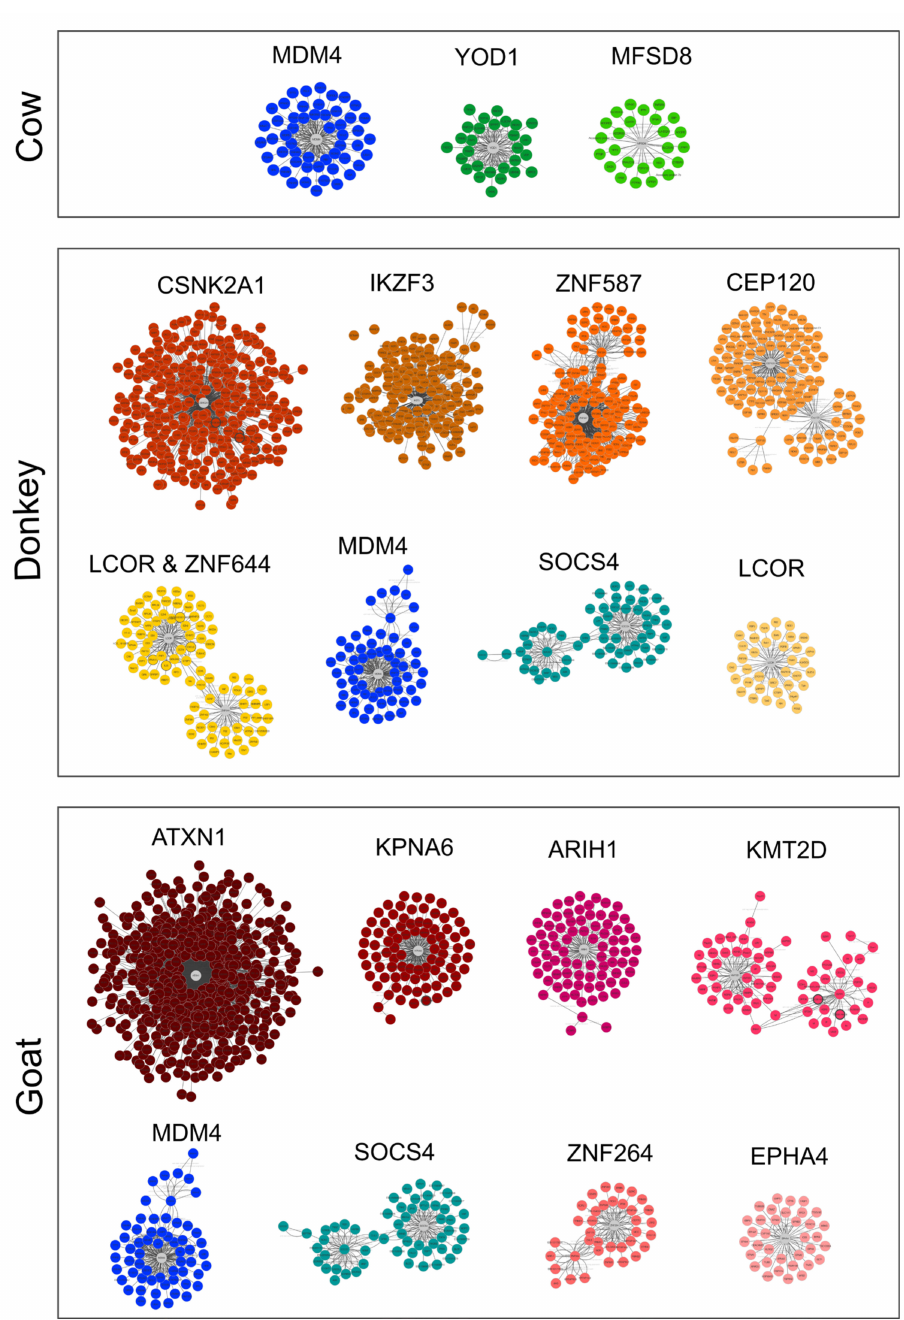
Figure 4. Clusters of proteins generated by clusterMaker 2.0 Cytoscape application starting from the PPI network. Central nodes (grey) indicate proteins with the higher number of interconnections. A consistent colour scheme was applied for clusters with the same central node in the different